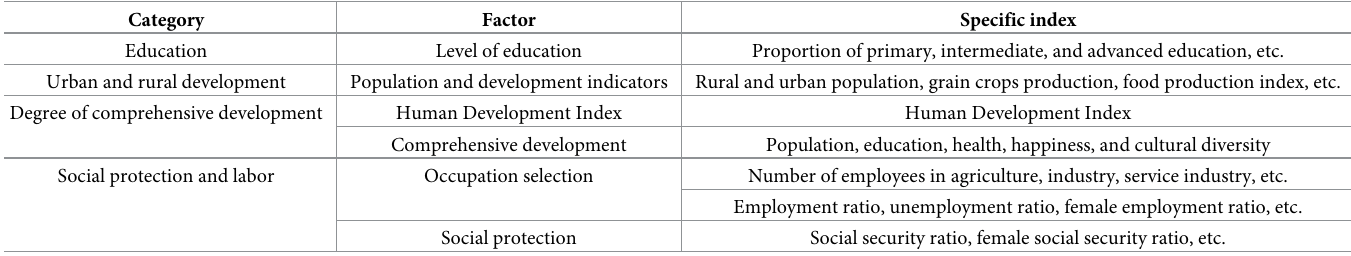
Table 2. Arctic geocultural index